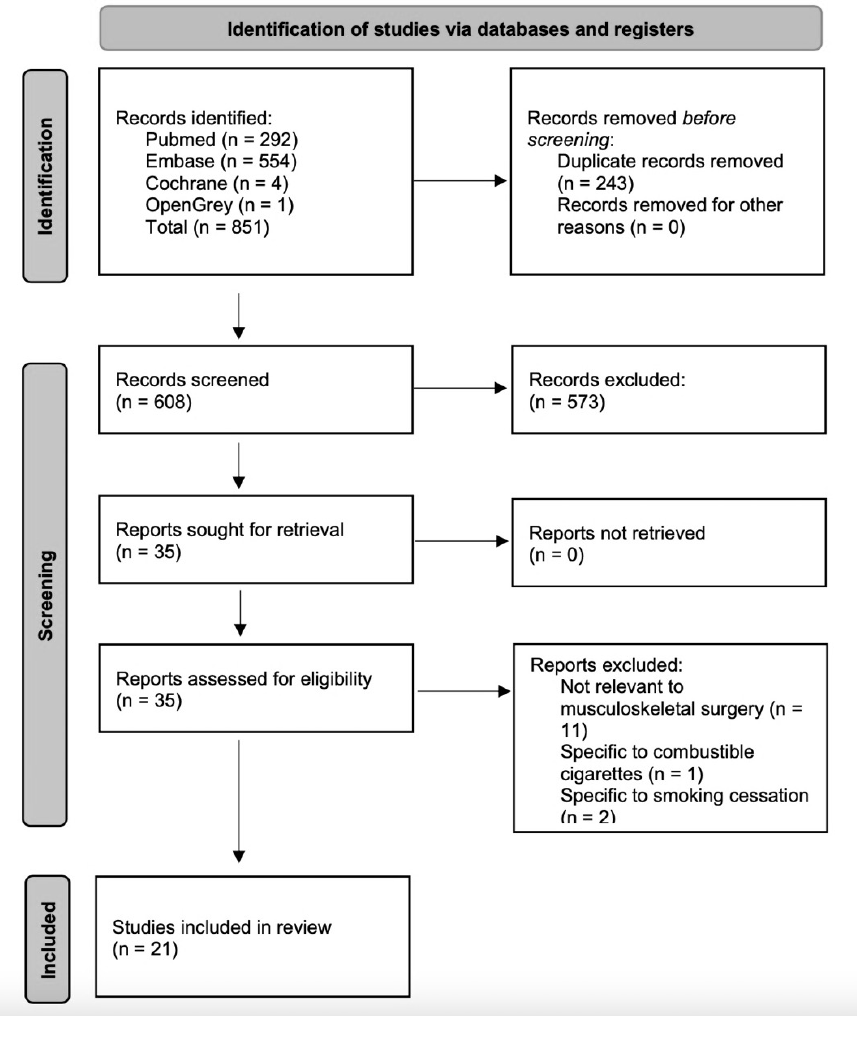
Figure 4. Systematic review flowchart.